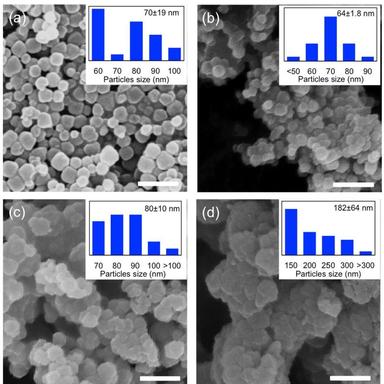
SEM images of AuCl4 @ZIF-8 with Au/Zn molar ratios of (a) 0:1, (b) 0.01:1, (c) 0.1: 1, and (d) 0.2:1. Reprinted with permission from Ref..